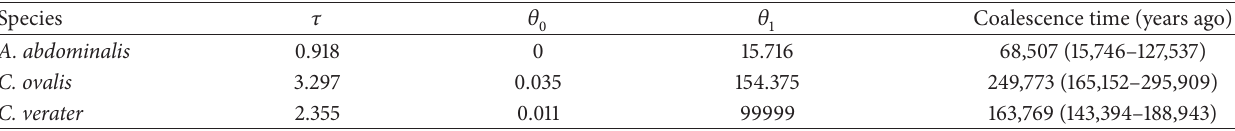
Table 2: Estimates of 𝜏 , pre and post-expansion theta ( 𝜃 0 and 𝜃 1 ), and coalescence time in years (95% confidence limit of 𝜏 ) for A. abdominalis, C. ovalis, and C. verater